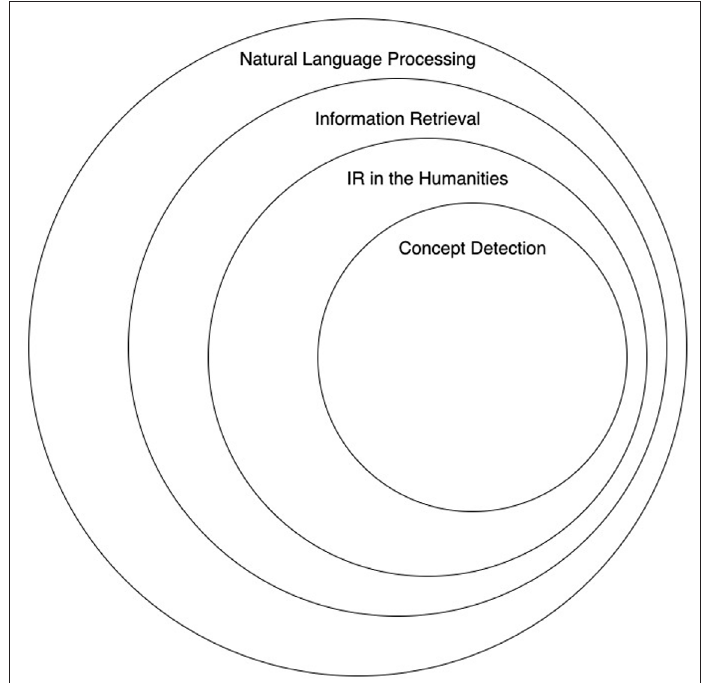
Figure 1: Concept Detection and its research